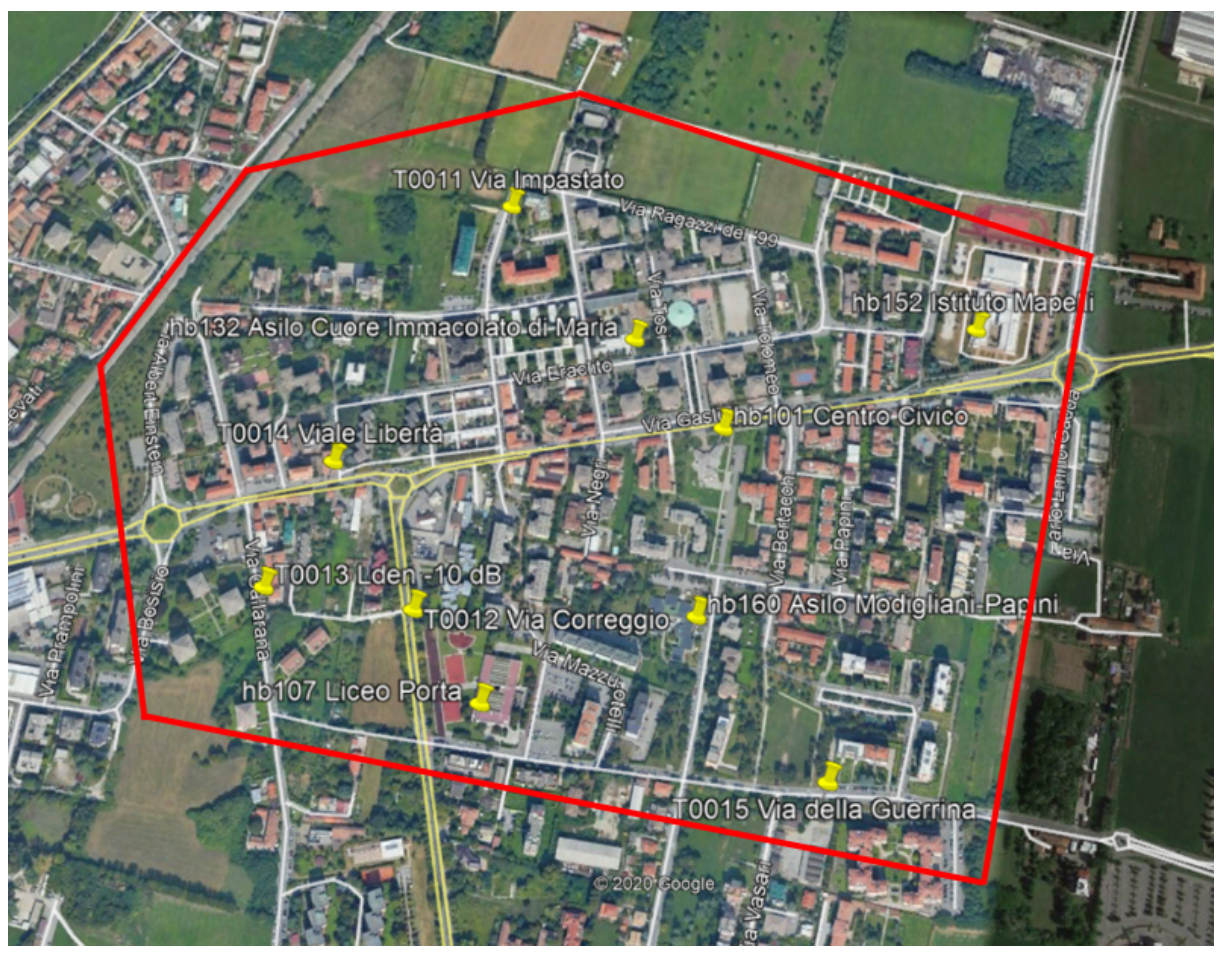
Figure 1: Smart noise monitoring system location in the Libertà district (in red the district